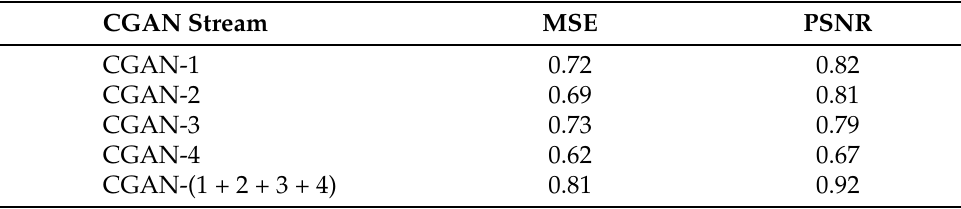
Figure 6. Evolution of AUC performance according to the size of SVM-train set. The vertical axis shows the AUC performances and the horizontal axis shows the size of SVM-train set corresponding to how many samples of the original test set. By increasing sequentially the SVM-train set size from 10% of the original test set size up to 80%, we report the evolution of performance. Obviously, the larger the size of SVM-train set we create, the better performance we obtain. Considering the effect of supervised scenario, we show that from 50% of the original test set size, we surpass state-of-the-art performance on Avenue, Ped1, and ShanghaiTech. Best viewed in color. Table 2. Frame-level AUC performance comparison between two methods of prediction error encoding: PSNR and MSE. Results are reported on Avenue dataset using SVM classifiers. 80% samples of test set are used for training